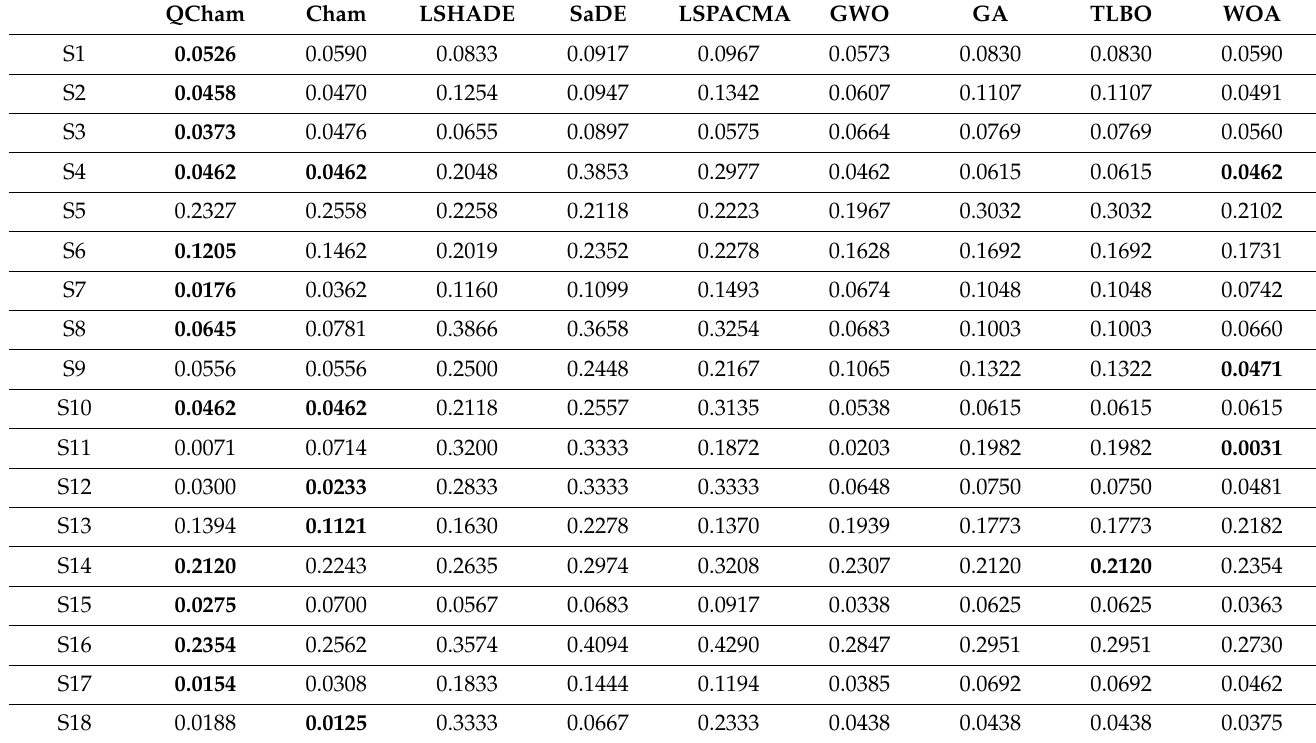
Table 4. Best fitness values for QCham and others.